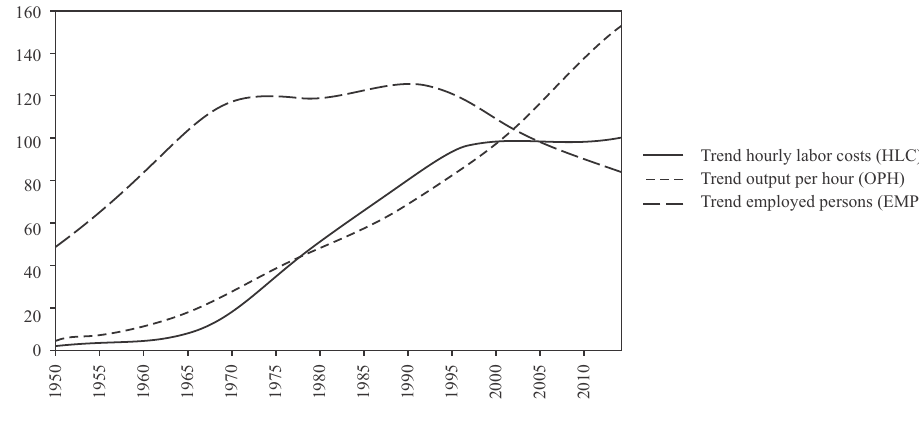
Fig.1b. The great decoupling in Japan